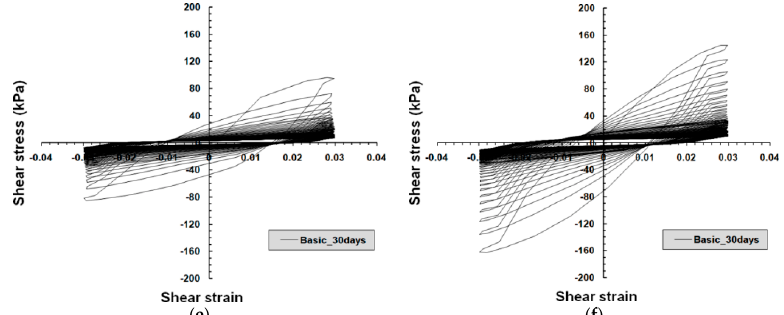
Figure 5. Typical shear stress–strain curves for the 30-day submersion period: ( a , c , e ) = 0.3 MPa of normal stress; and ( b , d , f ) = 0.6 MPa of normal stress.